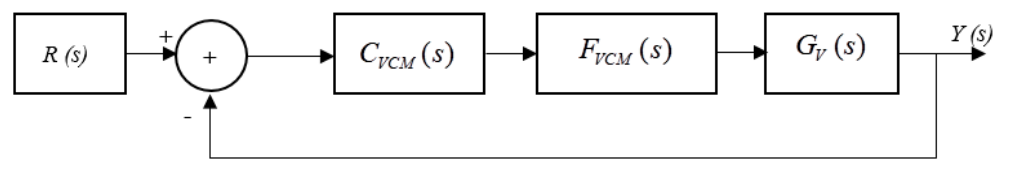
Figure 7. Single-stage control architecture .